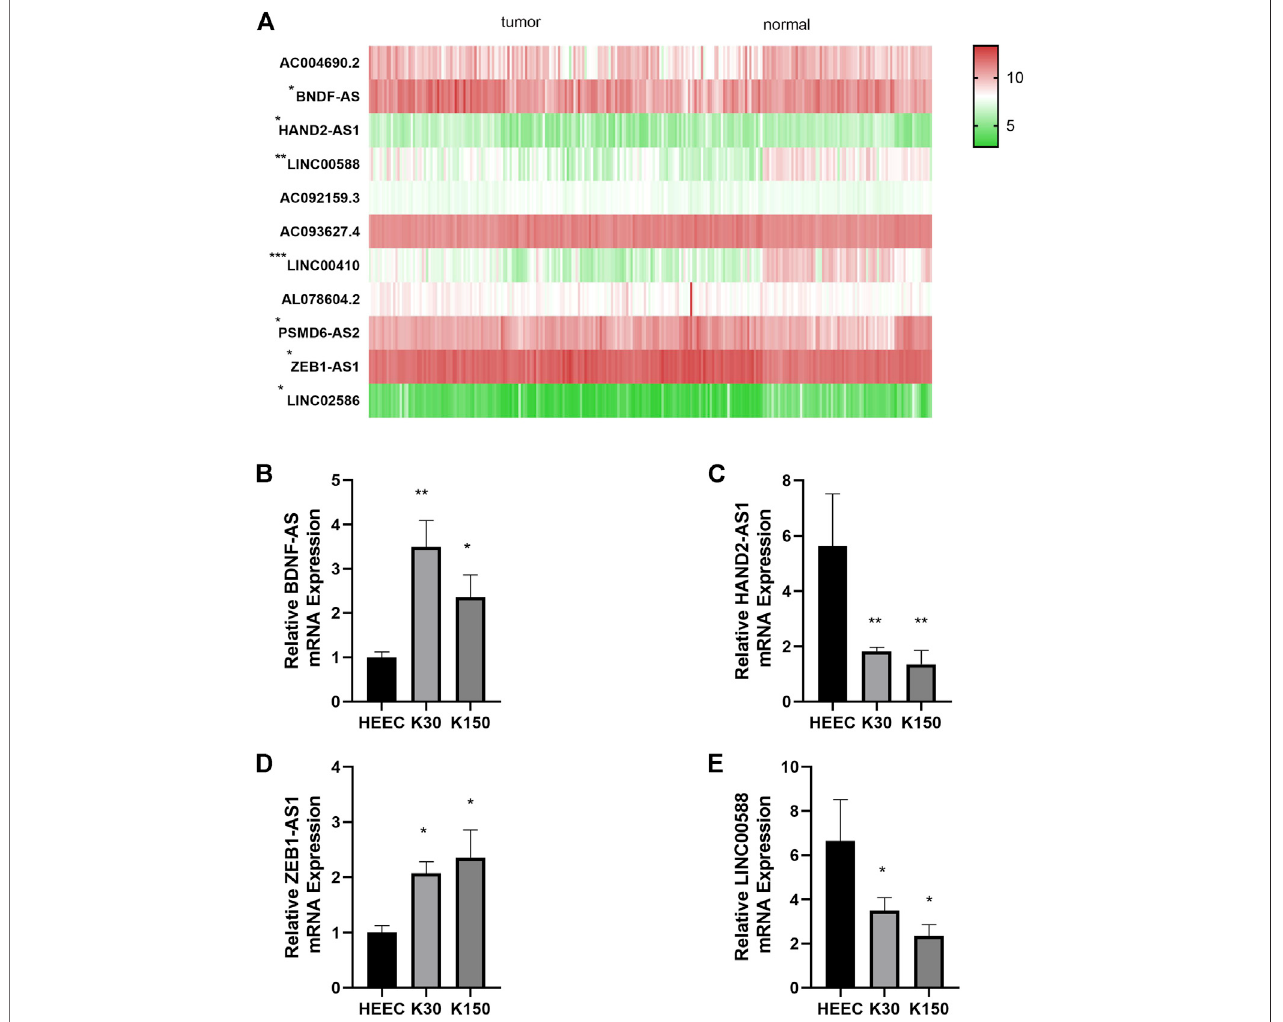
FIGURE 9 | Differential expression of autophagy-related lncRNAs. (A) : Differential expression of seven autophagy-related lncRNAs in cancer tissue vs. normal tissue (B) :RelativeBDNF-AS1expressioninHEEC,K30,K150cells. (C) :RelativeHAND2-AS1expressioninHEEC,K30,K150cells. (D) :RelativeZEB1-AS1expression in HEEC, K30, K150 cells. (E) : Relative LINC00588 expression in HEEC, K30, K150 cells.